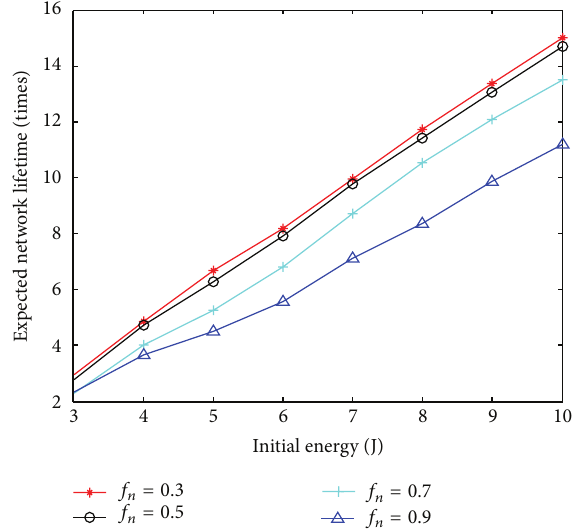
Figure 3: Expected lifetime for optimal lifetime with equal weight- ing factors.